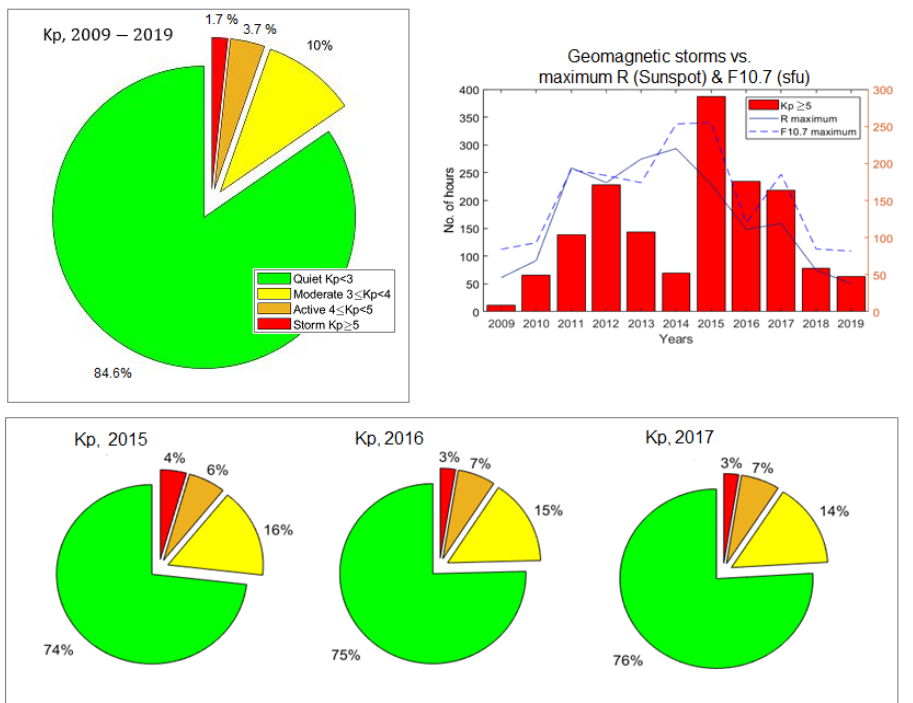
Figure 7. Percentage of Kp data with the values Kp < 3, 3 ≤ Kp < 4, 4 ≤ Kp < 5, and Kp ≥ 5 denoting quiet, moderate, active and storm conditions, respectively, in the geomagnetic field, over solar cycle 24 (2009–2019) (top left) and for years 2015, 2016 and 2017 (bottom). Top right: Number of hours of the Kp data with values Kp ≥ 5 vs. the maximum values of the sunspot number R and the solar radio flux F10.7 (both referring to the right y-axis) from 2009 to